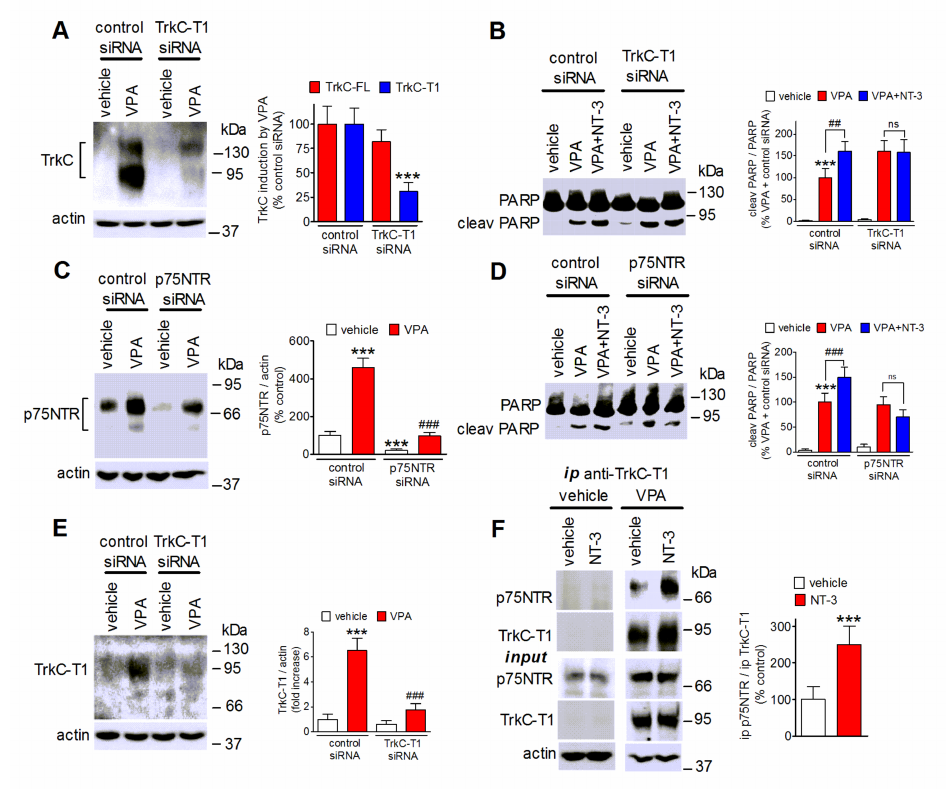
Figure 8. TrkC-T1 and p75NTR mediate NT-3 potentiation of VPA-induced apoptosis. ( A , C ) SH-SY5Y cells were transfected with either control siRNA, TrkC-T1 siRNA, or p75NTR siRNA and then